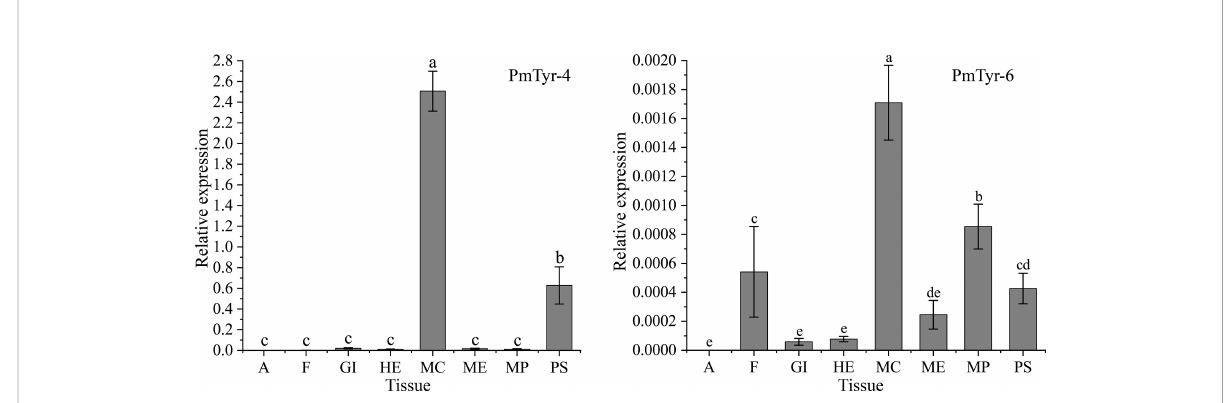
FIGURE 3 Expression patterns of PmTyr-4 and PmTyr-6 in different tissues. A, adductor muscle; F, foot; GI, gill; HE, hepatopancreas; MC, mantle central; ME, mantle edge; MP, mantle pallial; PS, pearl sac. Statistical signi fi cance was determined by Duncan-test. Error bars correspond to mean ± SD. Different lower-case letters (a, b, c, and d) were signi fi cantly different ( P<0.05 ), whereas same ones (a, b, c, and d) were not signi fi cantly different ( P>0.05